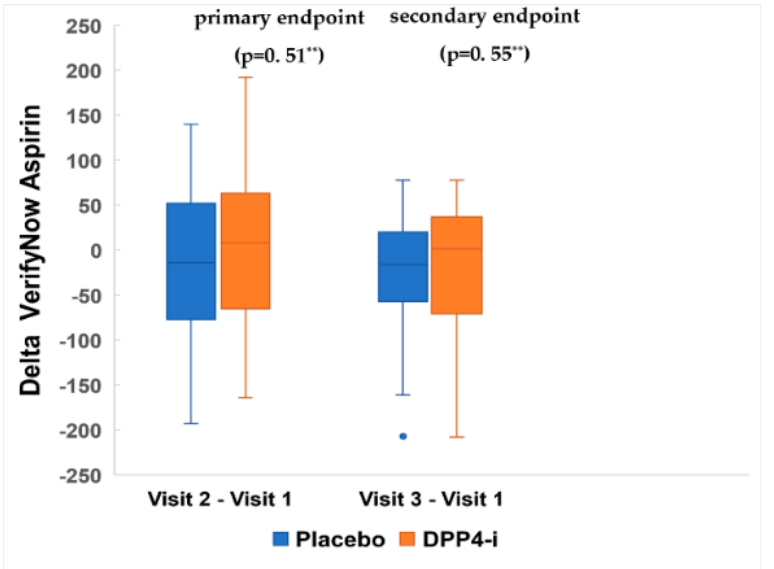
Figure 4. Changes ( ∆ ) in Platelet reactivity (IQR) by VerifyNow Aspirin. Visit 1: baseline. Visit 2: 4 ± 2 days. Visit 3: 30 ± 5 days. ∆ Visit 2—Visit 1: Placebo = − 14.00 ( − 77.00; 52.00); DPP4-i= 8.00 ( − 65.00; 63.00). ∆ Visit 3—Visit 1: Placebo = − 16.00 ( − 56.00; 18.00); DPP4-i = 1.50 ( − 68.50; 36.50). ** Mann–Whitney test results expressed as ARU: aspirin reaction units.